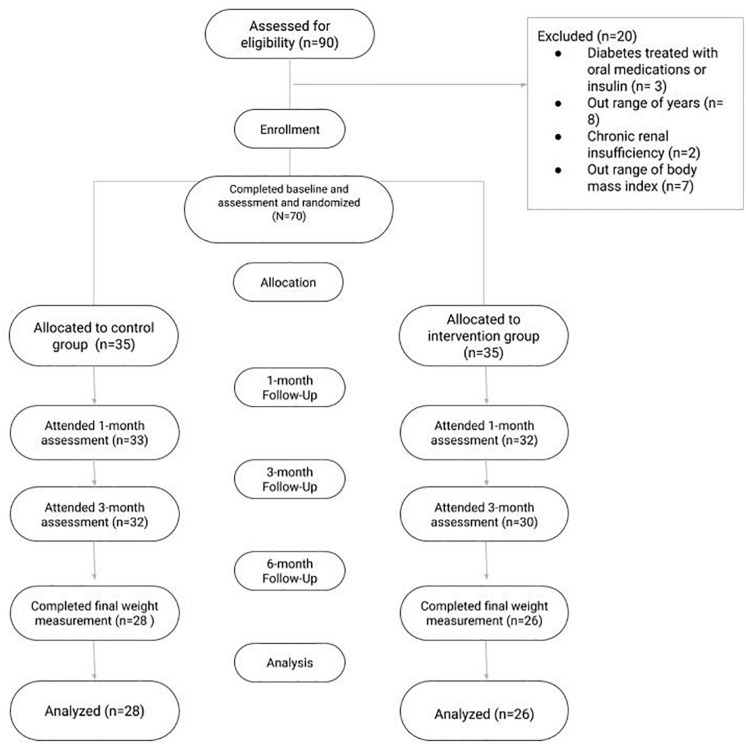
Consort diagram.